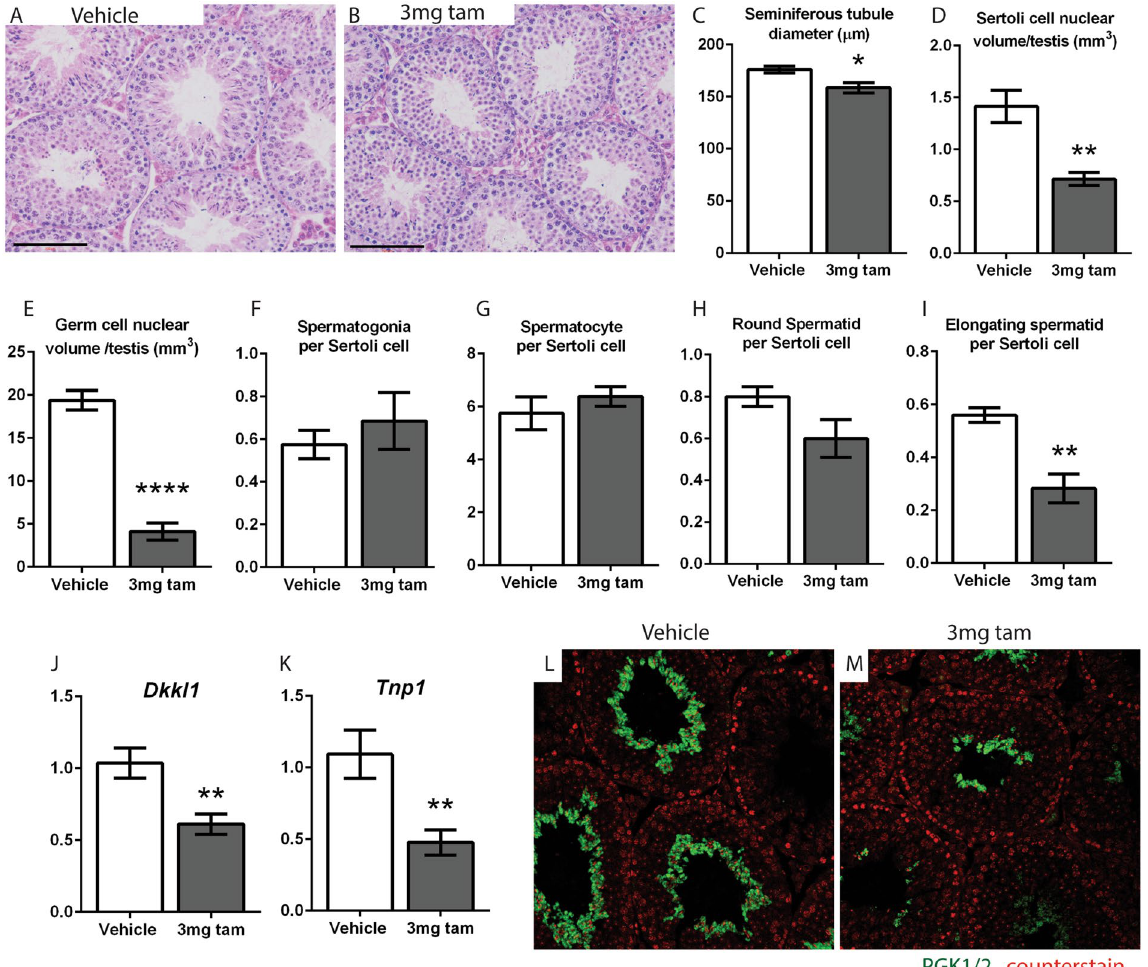
Figure 3. A single dose of 3 mg tamoxifen at d16 has long term effects on spermatogenesis. ( A , B ) C57bl/6 mice treated with tamoxifen at d16 have visibly normal testicular histology, with no gross changes to seminiferous tubule organisation at 7 weeks compared to controls. ( C ) The seminiferous tubules of tamoxifen-treated mice have a significantly smaller diameter than controls (n = 3 mice, 50 measurements per testis, error bars are SEM). Stereological cell counting reveals a significant reduction in ( D ) Sertoli cell volume and ( E ) germ cell volume per testis in tamoxifen-treated mice. ( F – H ) The number of spermatogonia, spermatocytes and round spermatids per Sertoli cell is unchanged. ( I ) The number of elongate spermatids per Sertoli cell is significantly reduced (cell counting measurements n = 4 mice, error bars are SEM). Testes from tamoxifen-treated mice also show significant reductions in the expression of ( J ) the spermatocyte marker Dkkl1 and ( K ) the spermatid marker Tnp1 (qPCRs n = 7, error bars are SEM). ( L ) Testes from tamoxifen-treated mice have a visibly reduced area of immunohistochemical staining for the spermatid marker PGK